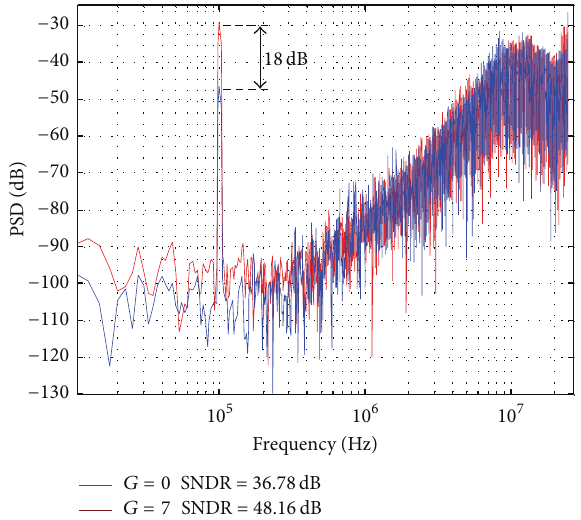
Figure 6: Simulated signal power